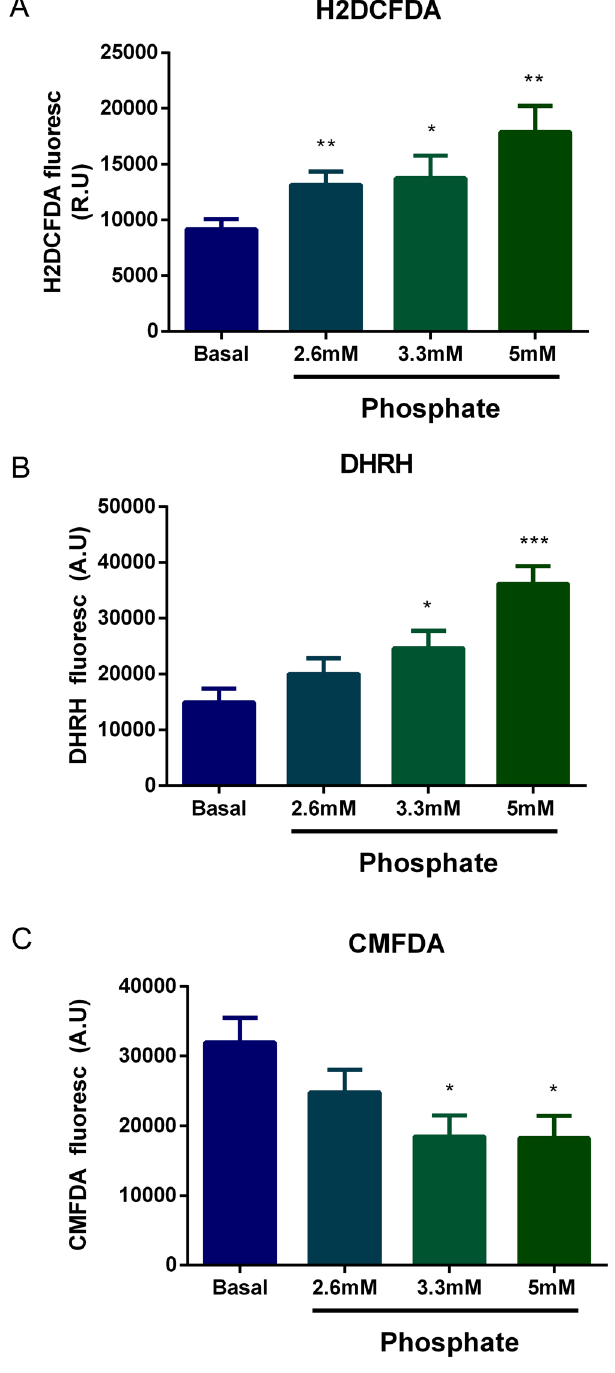
Figure 7. Phosphate increases Reactive Oxygen Species (ROS) in HEK-293 cells. Intracellular ROS was determined using the probes ( A ) H2DCFDA (detects presence of ROS unspecifically) ( B ) DHRH (determinates peroxynitrate) ( C ) CMFDA (detects levels of glutathione) after 24 hours of incubation with different concentrations of inorganic phosphate. (t-test analysis. * p < 0.05 vs basal phosphate; ** p < 0.01 vs basal phosphate; *** p < 0.001 vs basal phosphate. Basal phosphate is the content of phosphate in the culture medium at 0.9